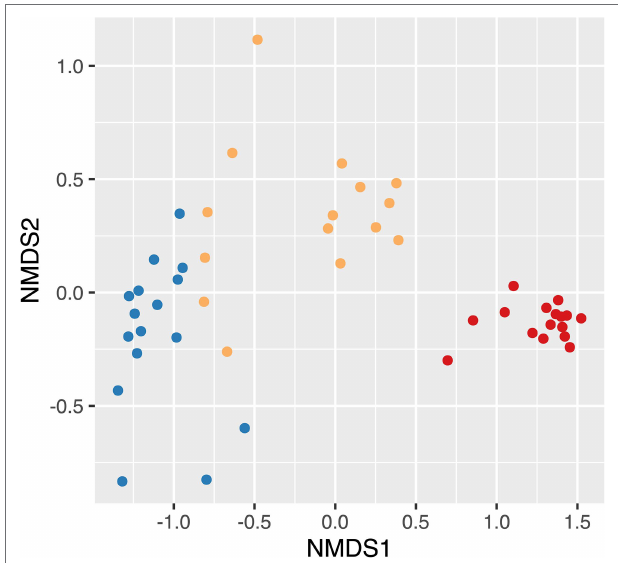
FIGURE 2 | Nonmetric multidimensional scaling (NMDS) based on Bray– Curtis dissimilarity distances showing the differences in beta diversity between undisturbed (UD), semi disturbed (SD), and most disturbed (MD) soil communities. Points colored by the level of Fairbanks Permafrost Experiment Station (FPES) soil disturbance with blue = UD ( n = 16), gold = SD ( n = 15), and red = MD ( n = 16).